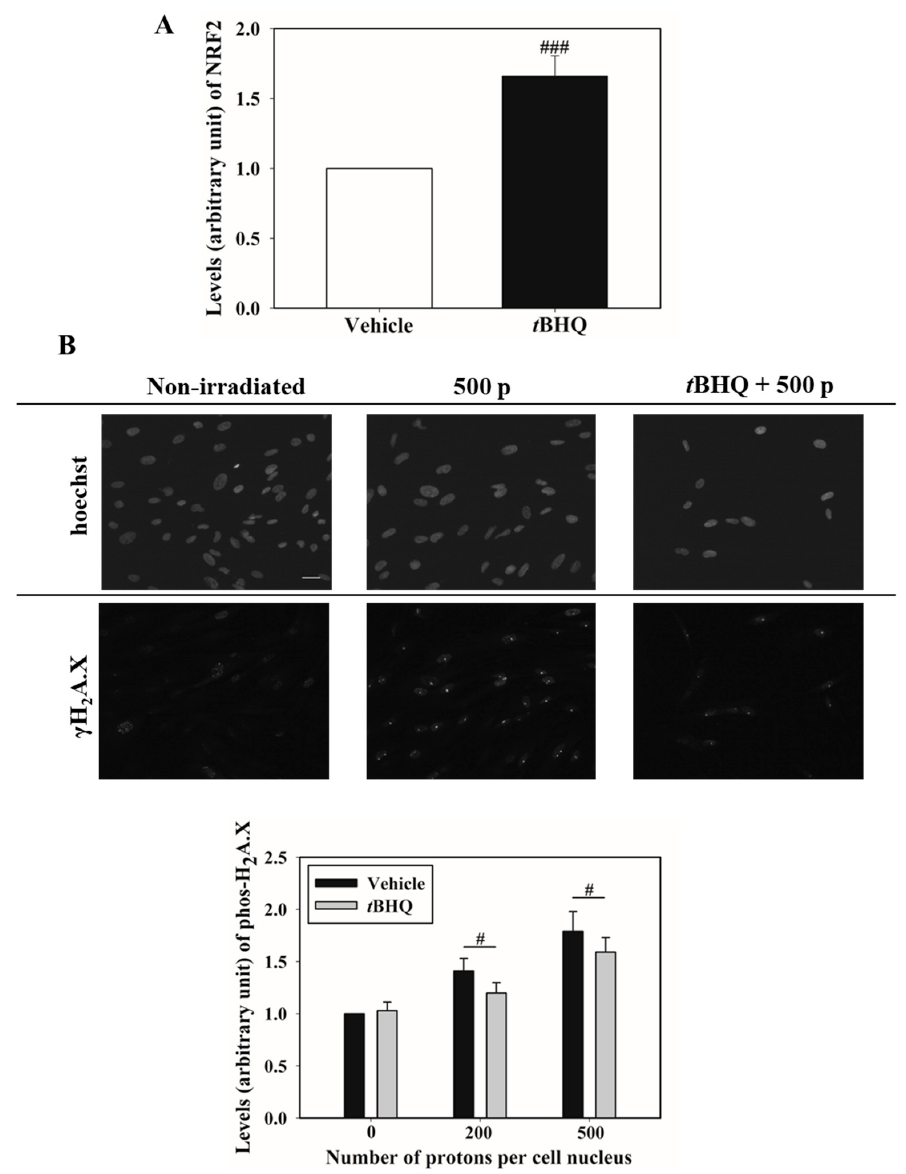
Figure 3. WI-38 cells were treated with 15 µmol/L of tBHQ or the vehicle for 16 h. Then, the nucleus accumulation of NRF2 was identified by immunofluorescence staining ( A ). WI-38 cells were treated with 15 µmol/L of tBHQ or the vehicle for 16 h. Then, the cell nucleus was targeted with 200 or 500 protons. Three hours later, the levels of γ -H 2 A.X were detected by immunofluorescence staining. Scale bar = 30 µm ( B ). # P value < 0.05. ### P value < 0.001.